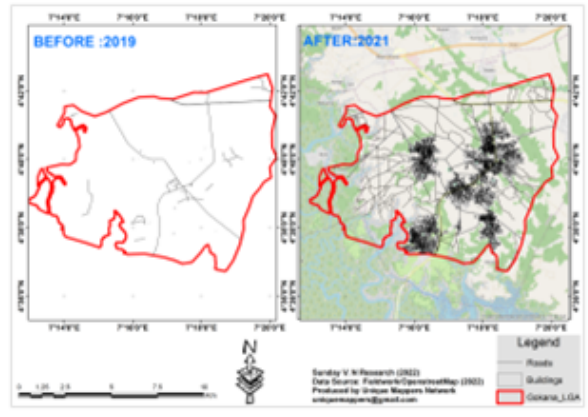
Figure 16: Before and After 28 months of OpenStreetMap by LVM for Gokana